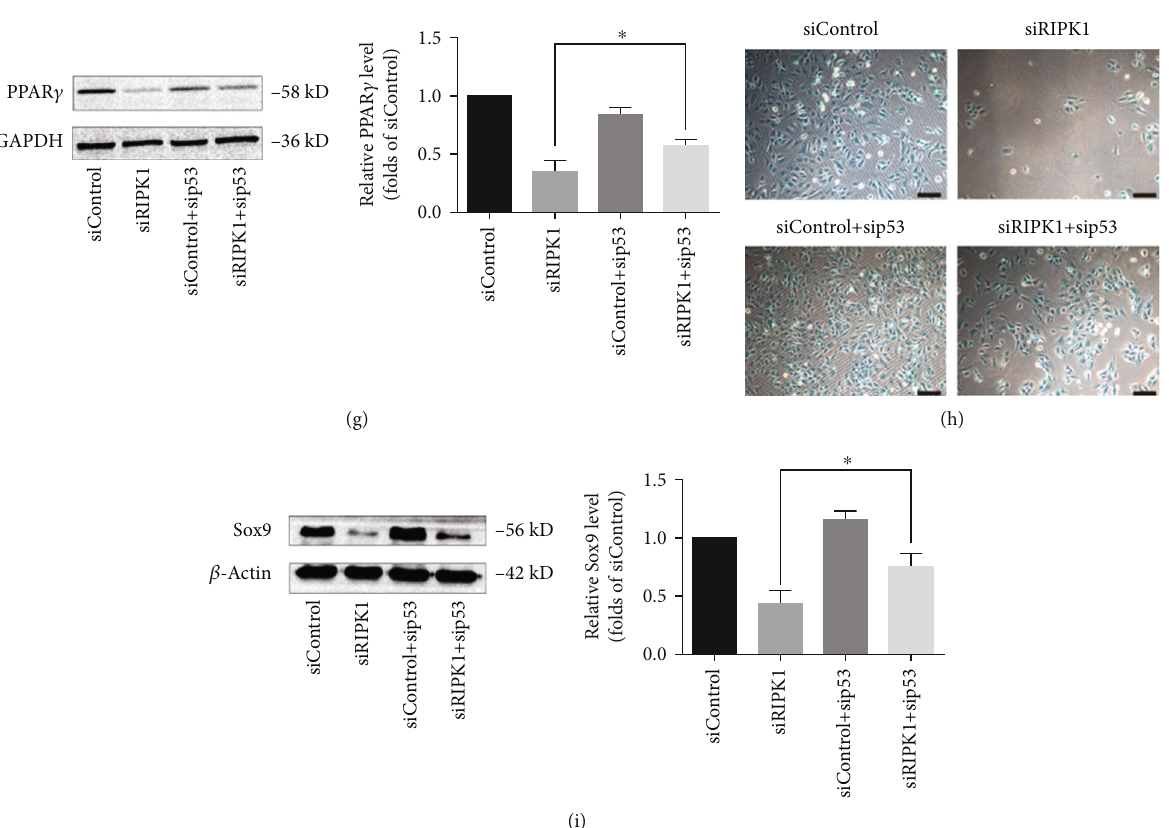
Figure 4: RIPK1 regulated proliferation and di ff erentiation of bone marrow MSCs via p53. (a) Representative western blots for the expression of p53. p53 expression was upregulated in bone marrow MSCs following RIPK1 inactivation. Histogram analysis showing the relative protein levels of p53. Data are presented as the means ± SD from three independent experiments ( ∗ p < 0 : 05 , vs. 0h group; n = 3 ). (b) The bone marrow MSCs were transfected with sip53 for 24 h; then, the knockdown e ffi ciency of p53 was assessed by western blotting. Representative western blots of the expression of p53. Histogram analysis showing the relative protein levels of p53. Data are presented as the means ± SD from three independent experiments ( ∗ p < 0 : 05 , vs. siControl; n = 3 ). sip53(#1) showed the highest e ffi ciency among three sip53. (c) The inhibition e ff ect of siPIRK1 on cell proliferation was signi fi cantly reversed by sip53, by CCK-8 assay. Values are expressed as the means ± SD from three independent experiments ( ∗ p < 0 : 05 , vs. siRIPK1; n = 3 ). (d) Alizarin Red staining showed the inhibition of siRIPK1 on osteogenic di ff erentiation was reversed by sip53, and (e) Runx2 expression level in siRIPK1 was increased after transfected with sip53. Values are expressed as the means ± SD from three independent experiments ( ∗ p < 0 : 05 , vs. siRIPK1; n = 3 ) ( scalebar = 200 μ m). (f) Oil Red O staining showed the inhibition of siRIPK1 on adipogenic di ff erentiation was reversed by sip53, and (g) PPAR γ expression level in siRIPK1 was increased after transfected with sip53. Values are expressed as the means ± SD from three independent experiments ( ∗ p < 0 : 05 , vs. siRIPK1; n = 3 ) ( scale bar = 100 μ m). (h) Alcian Blue staining showed the inhibition of siRIPK1 on chondrogenic di ff erentiation was reversed by sip53, and (i) Sox9 expression level in siRIPK1 was increased after transfected with sip53. Values are expressed as the means ± SD from three independent experiments ( ∗ p < 0 : 05 , vs. siRIPK1; n = 3 ) ( scale bar = 100 μ